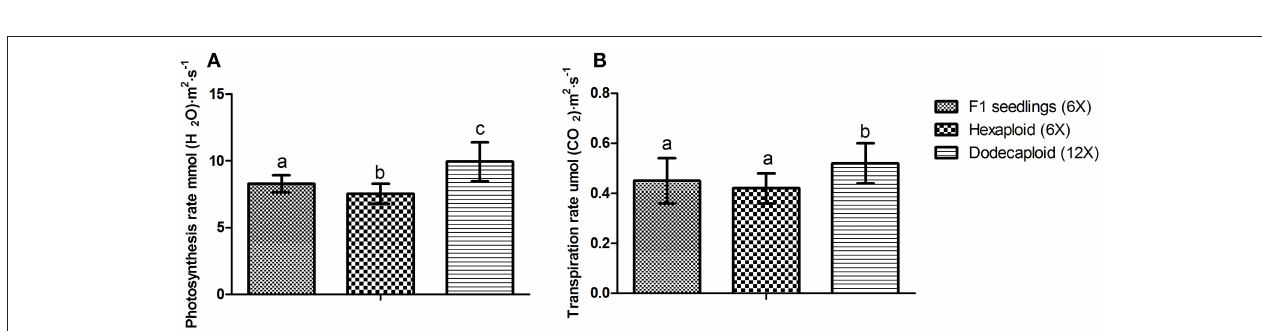
FIGURE 4 | Comparison of photosynthesis and transpiration rates between seedlings and anther-regenerated plants of Dendrocalamus latiflorus . (A) Photosynthesis rate, (B) Transpiration rate. Different capital letters indicate a significant difference between ploidy levels at p < 0.05 ( Duncan, 1955).